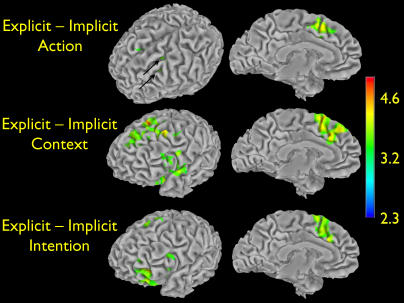
Significant Signal Changes in Subjects Receiving Explicit Instructions Compared to Subjects Receiving Implicit Instructions in the Three Tasks Versus RestThreshold of Z = 2.3 at voxel level and a cluster level corrected for the whole brain at p < 0.05. The two black arrows indicate two foci of activity in dorsal premotor cortex that are located deep in the sulci and thus not easily visible on the three-dimensional surface rendering. See Tables S3–S5 for coordinates of local maxima.